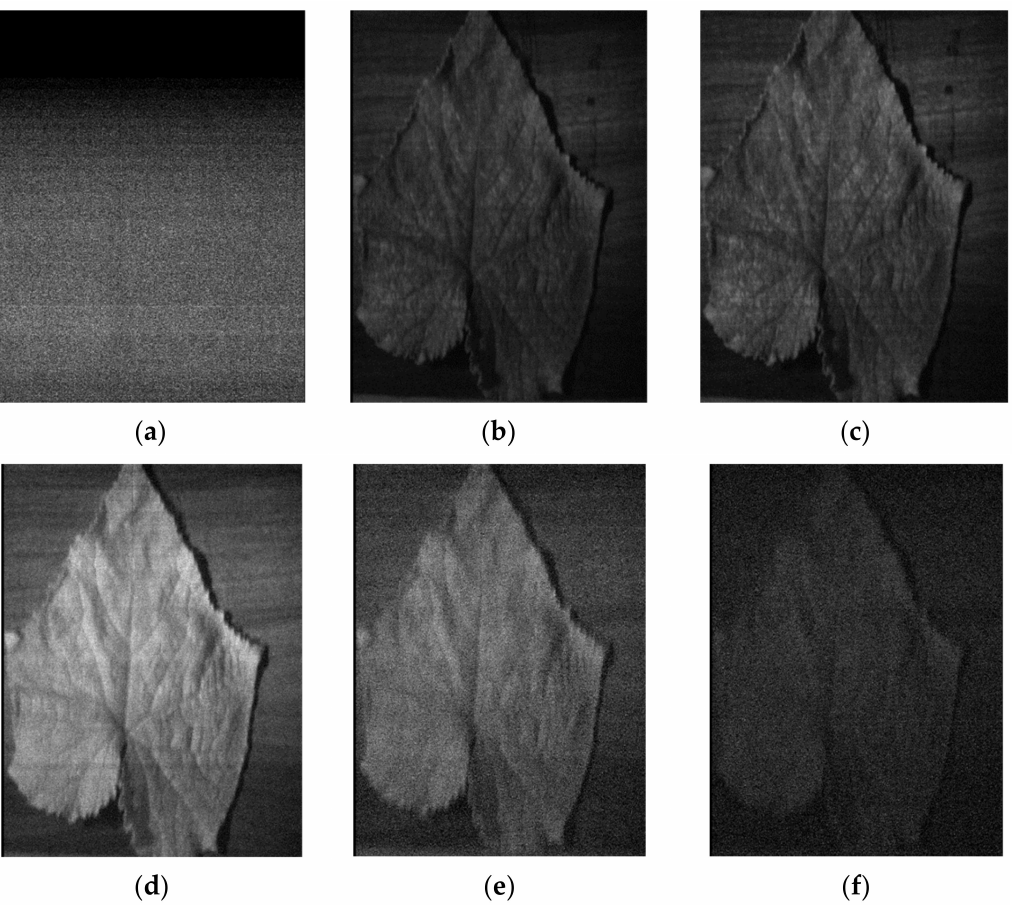
Figure 4. Some examples of the hyperspectral images of cucumber leaves in the range of wavelengths from 400 to 1100 nm: ( a ) 420 nm; ( b ) 540 nm; ( c ) 690 nm; ( d ) 800 nm; ( e ) 950 nm; ( f ) 1040